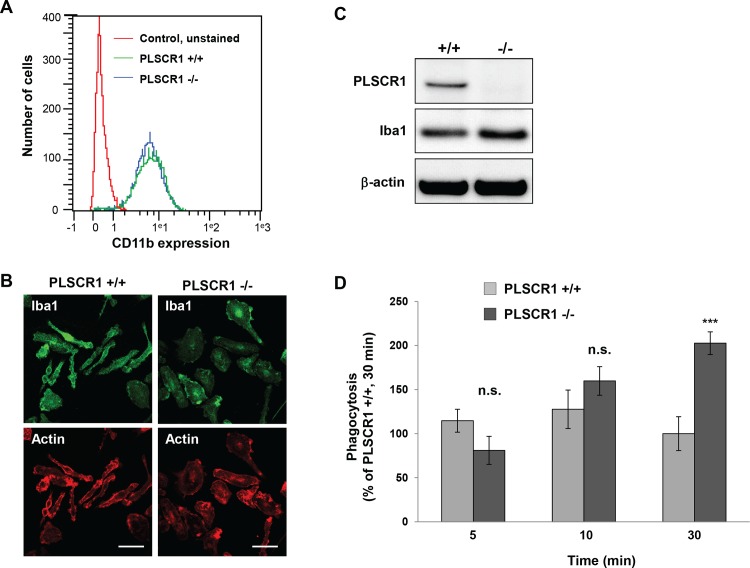
Characterization of bone marrow-derived macrophages from PLSCR1 kwock-out mice and their phagocytotic activity.(A) Histogram of CD11b expression by cells in BMDM cultures obtained from flow cytometric analysis of viable cells labelled with V450-anti-CD11b antibodies. Control sample was unstained. Nearly all cells (97%) in both PLSCR1 +/+ and PLSCR1 -/- cultures expressed the macrophage marker CD11b with similar MIFs, 6.7 and 7.0 respectively. (B) Confocal images of BMDM cultures prepared from PLSCR1 +/+ and PLSCR1 -/- mice. Cells were fixed and stained for F-actin with TRITC-phalloidin and macrophages were immunolabeled for Iba1 and visualized with a secondary antibody conjugated to Alexa 647. Bars, 50 μm. (C) Western blot of cell lysates (20 μg of total protein) of BMDM cultures from PLSCR1 +/+ and PLSCR1 -/- mice confirm the absence of PLSCR1 in knock-out mice. Blots were revealed with antibodies against PLSCR1, Iba1 and β-actin as loading control. (D) BMDMs from PLSCR1 +/+ (grey bars) or -/- (black bars) mice were incubated for 5, 10 or 30 min at 37°C with IgG-opsonized SRBCs, stained with Alexa488-anti-Rabbit IgG to detect external SRBCs before permeabilization and fixation for labeling of all associated SRBCs including internalized particles with Alexa647-anti-Rabbit IgG. The number of external SRBCs and the total number of cell-associated SRBCs were counted for at least 50 cells. Results are expressed as the percentage of cell-associated (internal and external) SRBCs/cell relative to that measured after 30 min of phagocytosis in BMDMs from PLSCR1 +/+ mice. Statistical significance was determined by the non parametric statistical hypothesis using the Mann-Whitney U test (n.s., p>0.05; ***, p<0.001).